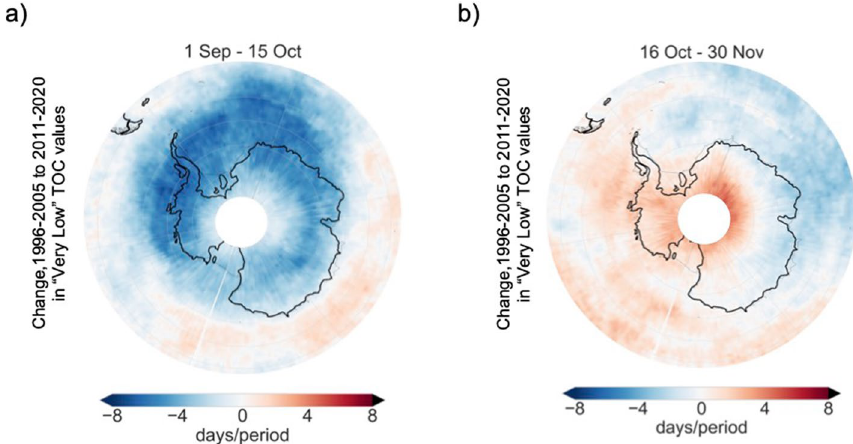
Figure 3. The number of late spring days with “very low” values of the total ozone column has not significantly changed during the last two decades. Changes from 1996–2005 to 2011–2020 in the number of days with “very low” TOC values (defined according to the 10th percentile), over the periods: 1 September–15 October ( a ) and 16 October–30 November ( b ). Data from the TOMS instrument on the Earth Probe satellite and from the OMI instrument onboard the Aura satellite were used in plots ( a , b ). The plots were generated using Python’s Matplotlib library 71